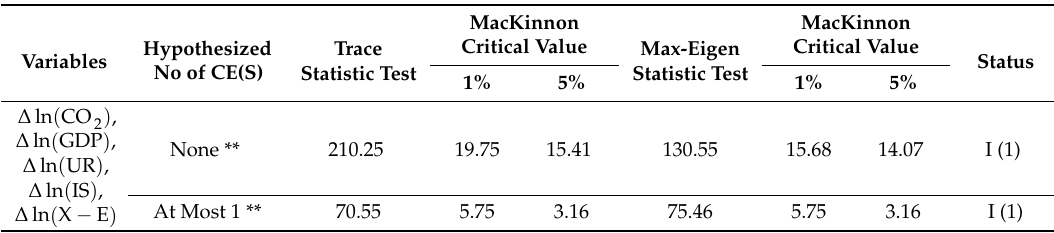
Table 2. Co-integration test by Johansen Juselius.